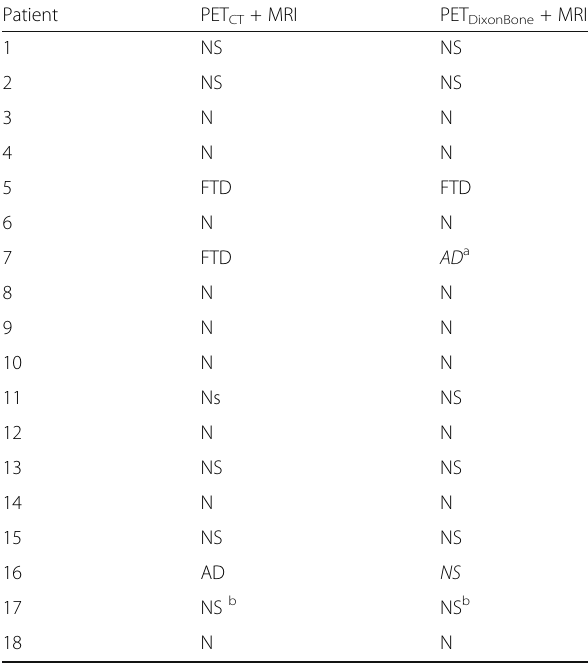
Table 6 Assigned diagnostic categorization made by one nuclear medicine physician (reader 3) and one neuroradiologist in conjunction for PET (PET CT , PET DixonBone ) and MRI. Discrepancies from PET CT + MRI are italicized